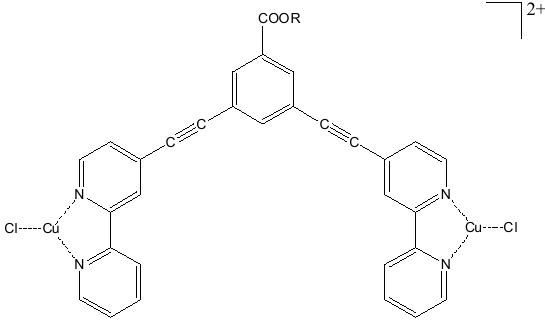
Scheme 3. Reasonable structure of ions [L+Cu